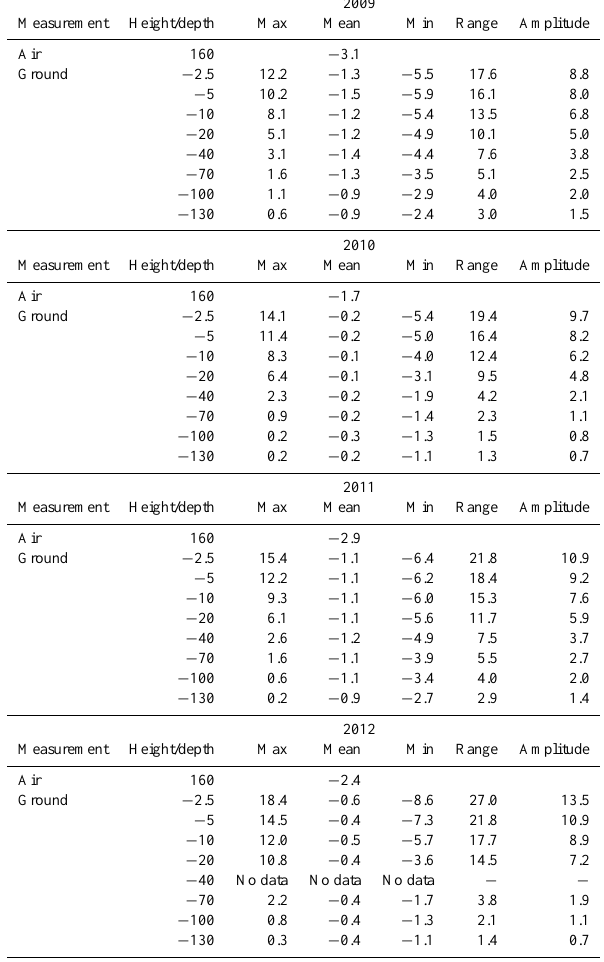
Table 8. Maximum, mean and minimum annual temperatures (in ◦ C) of the air and the ground at different depths (incm), and the calculated range and